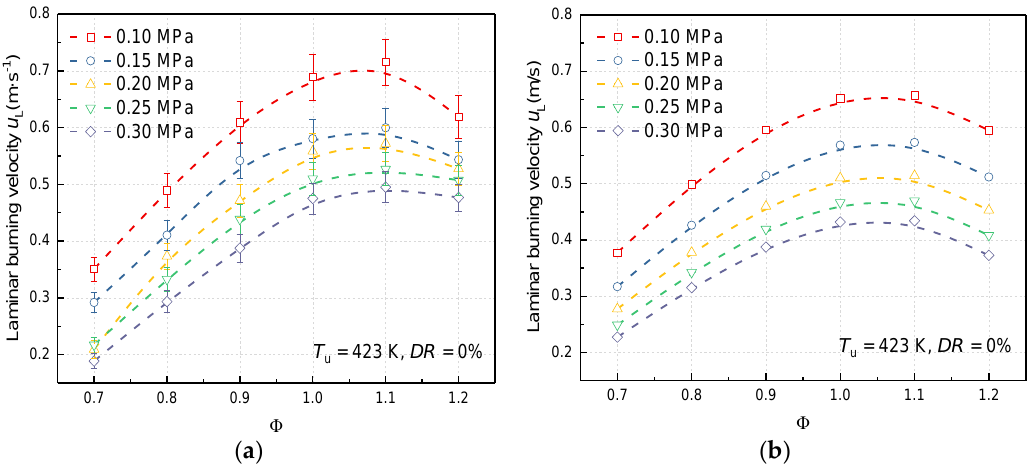
Figure 5. Laminar burning velocities under different initial pressures (initial temperature of 423 K, dilution rate of 0%). ( a ) From Schlieren; ( b ) From Chemkin.